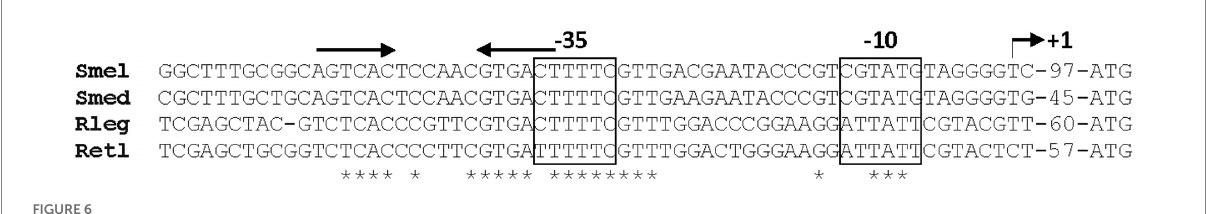
FIGURE 6 Alignment of srlA promoter region and analogous regions from other rhizobial genomes. srlA TSS (+1) from Schlüter et al. (2013) and experimentally verified (angled arrow) and distance to ATG start codon indicated. –10 and − 35 subsequences (boxed) from Schlüter et al. (2013). Conserved inverted repeat indicated by arrows. Nucleotide conservation indicated by asterisks. Smel, S. meliloti 1,021 (locus SMc03845, srlA ); Smed, Sinorhizobium medicae WSM419 (locus Sme_3082); Rleg, Rhizobium leguminosarum 3,841 (locus RL4535); Retl, Rhizobium etli CFN42 (locus RHE_CH03943).